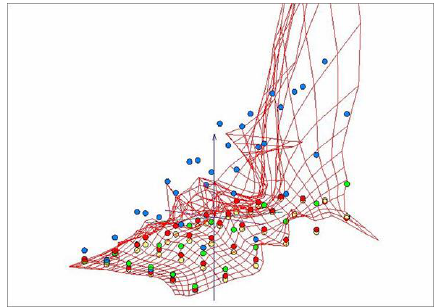
Figure 3. Elastic map for the array of errors for different OpenFOAM solvers